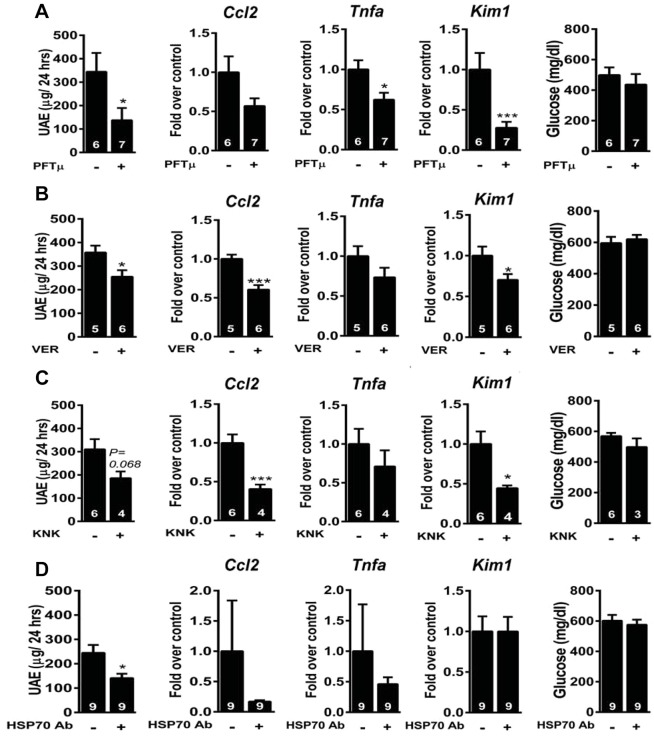
HSP70 blockade in DN mice. UAE, expression of Ccl2, Tnfa and Kim1 and concentrations of glucose in 2-week-diabetic mice that received pifithrin-μ (5 mg/kg; A), VER-155008 (16 mg/kg; B), KNK437 (25 mg/kg; C) or anti-HSP70 or isotype-matched IgM antibodies (D) intraperitoneally for 1 week. *P<0.05 and ***P<0.001 by Student's t-test.